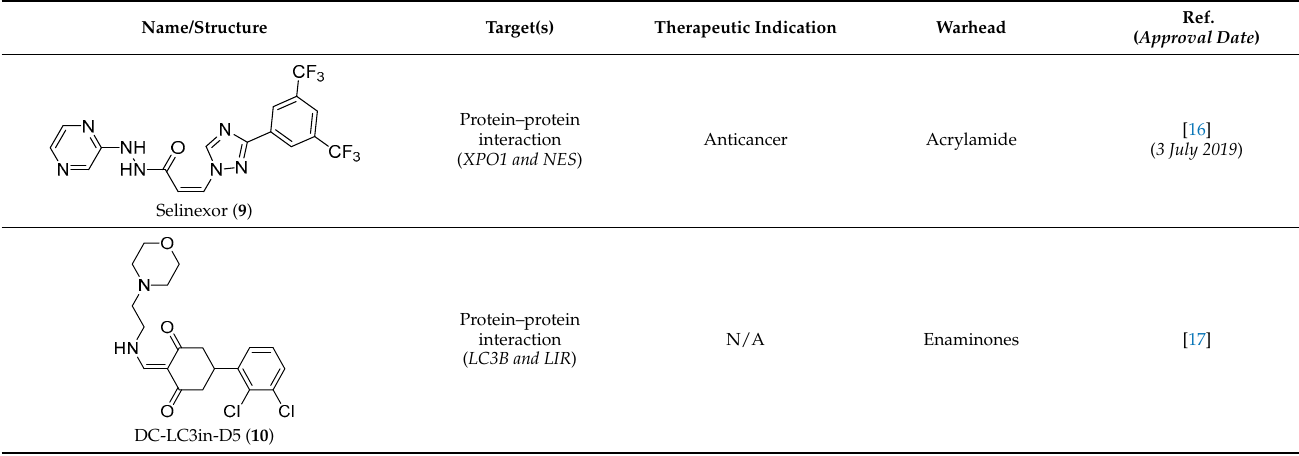
Table 3. Representative examples of expanded targeted covalent inhibitors (or modulators).